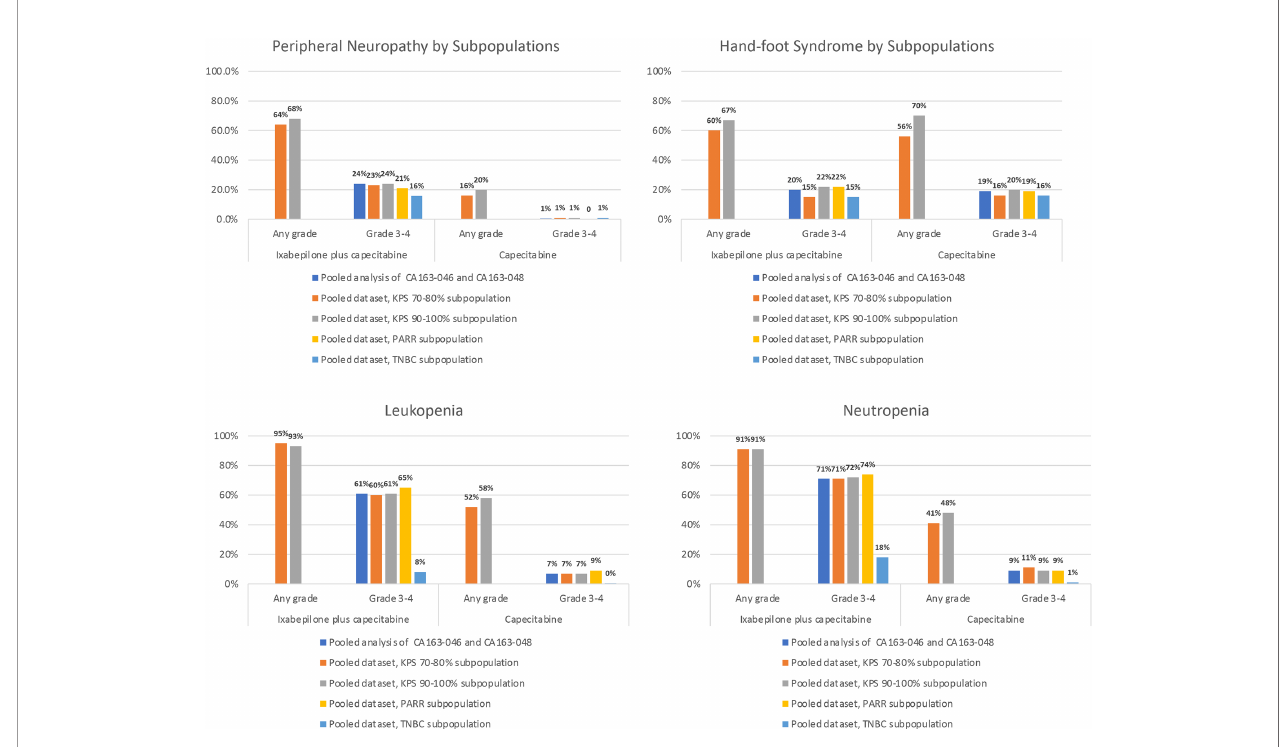
FIGURE 2 | Incidence of the Most Common Non-Hematologic TRAEs Associated With I-C and C in Subpopulations. Incidence of peripheral neuropathy, hand-foot syndrome, leukopenia, and neutropenia in subpopulations of the pooled analysis of CA163-046 and CA163-048 (30, 31, 33). I, ixabepilone; I+C, ixabepilone plus capecitabine; KPS, Karnofsky Performance Status; PPAR, post-adjuvant rapidly relapsing; TNBC, triple-negative breast cancer; TRAE, treatment-related adverse